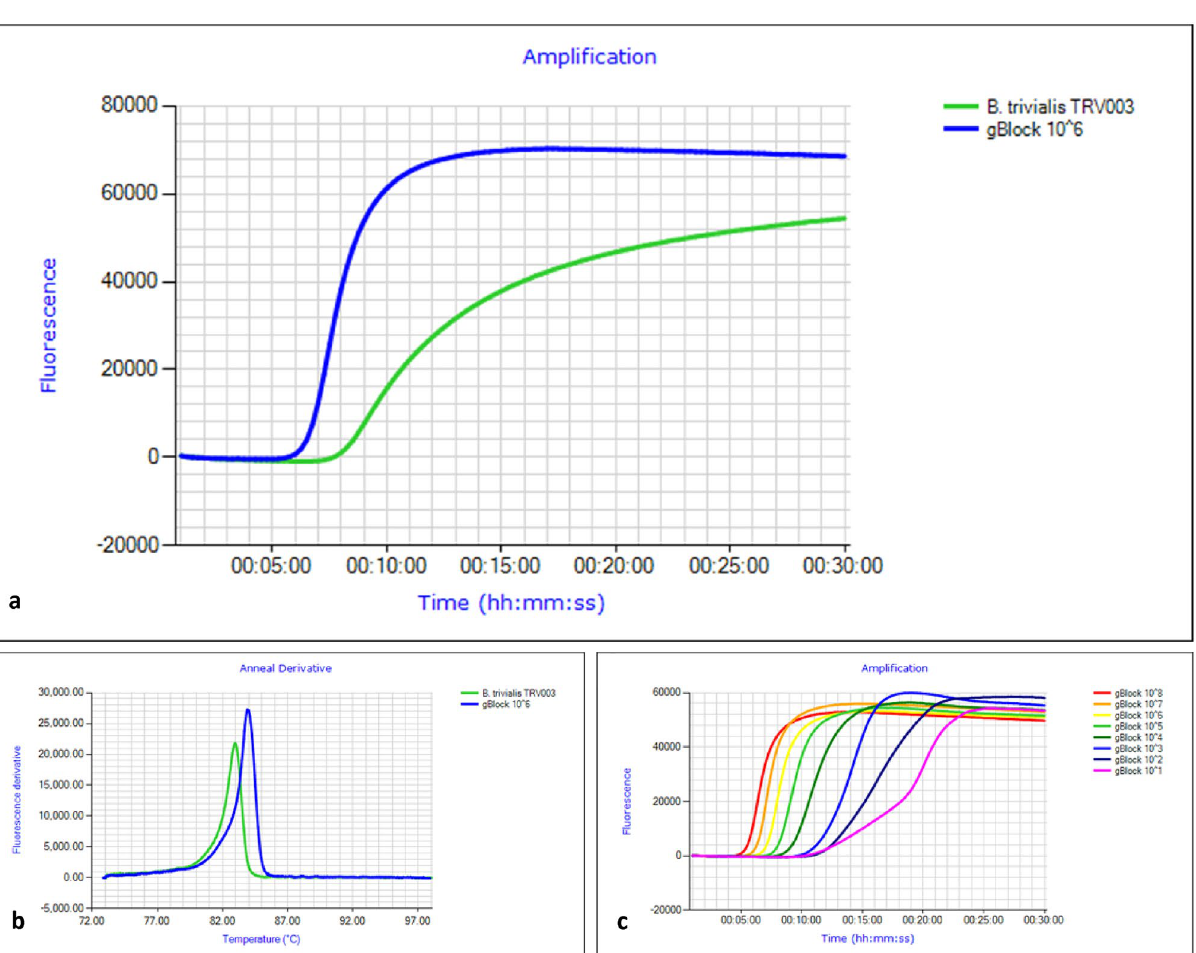
Figure 1. ( a ) Comparison of amplification of gBlock positive control and Bactrocera trivialis TRV003 DNA in the BtrivCOI LAMP assay. ( b ) Anneal derivative of gBlock positive control and Bactrocera trivialis TRV003 DNA in the BtrivCOI LAMP assay; in thisLAMP run the gBlock positive anneals at ~ 84 °C, while B. trivialis DNA anneals at ~ 83 °C. The gBlock positive 1 × 10 6 copies/µL is the appropriate concentration for use as a control. ( c ) BtrivCOI assay gBlock standard curve run with serial dilutions from 1 × 10 8 copies/µL to 1 × 10 1